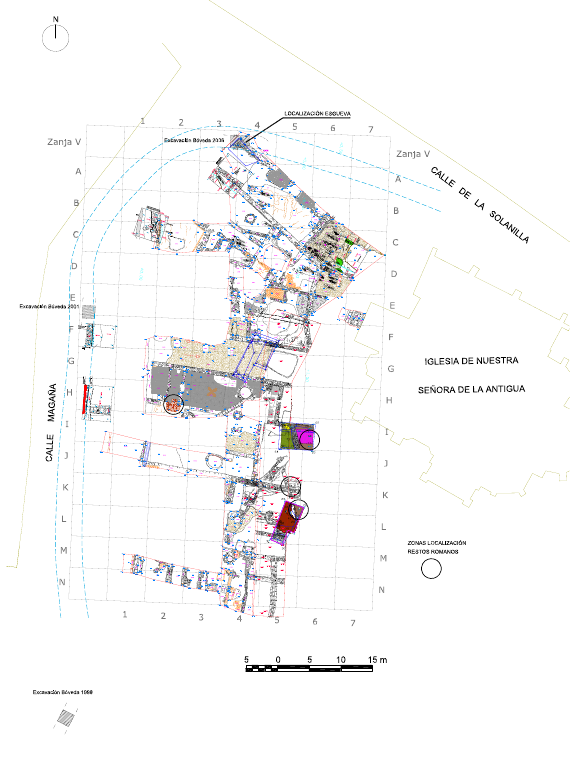
Figure 6: The archaeological remains and the current location of “La Antigua” church.